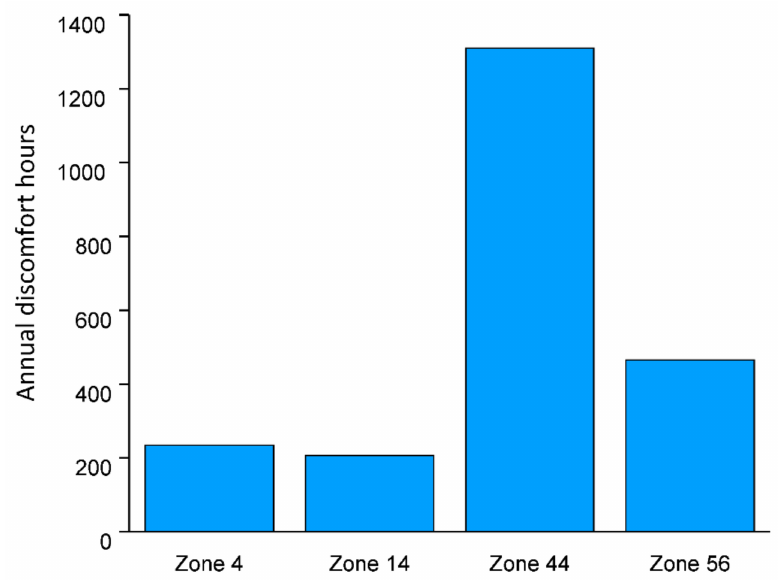
Figure 14. Number of annual discomfort hours during occupancy time based on EN 16798-1 in case A (no low-E